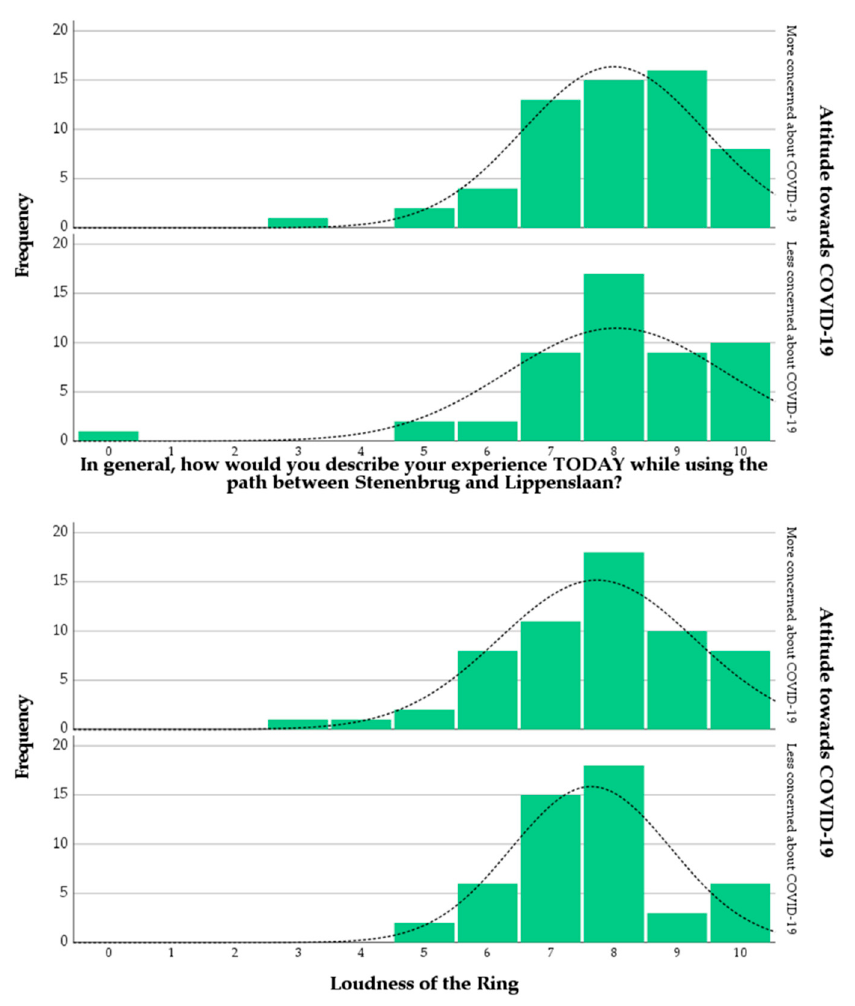
Figure 4. Distributions of the scores for the items of category (a) ( top ) and category (d) ( bottom ) of the questionnaire, split by ATC19.